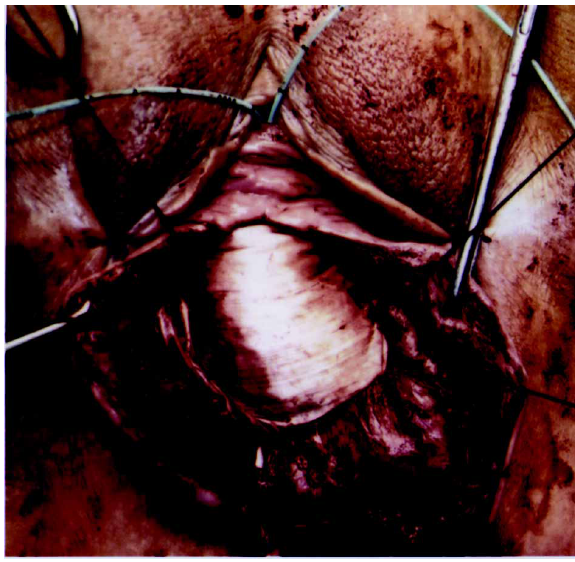
Figure 4 – Corrected cystocele, initiating the repair of the addi- tional